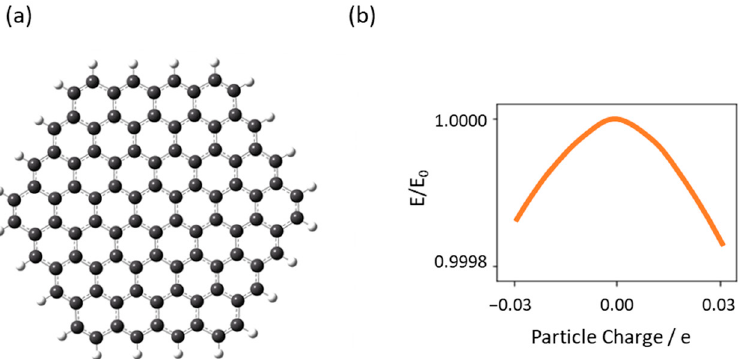
Figure 3. ( a ) Model graphene fragment for Hartree–Fock calculations. Carbon and hydrogen atoms are represented by black and white spheres, respectively. CC and CH bonds are represented by a black stick. ( b ) Relative stability of graphene with partial charges when E 0 is set to the graphene stability at neutral charge.